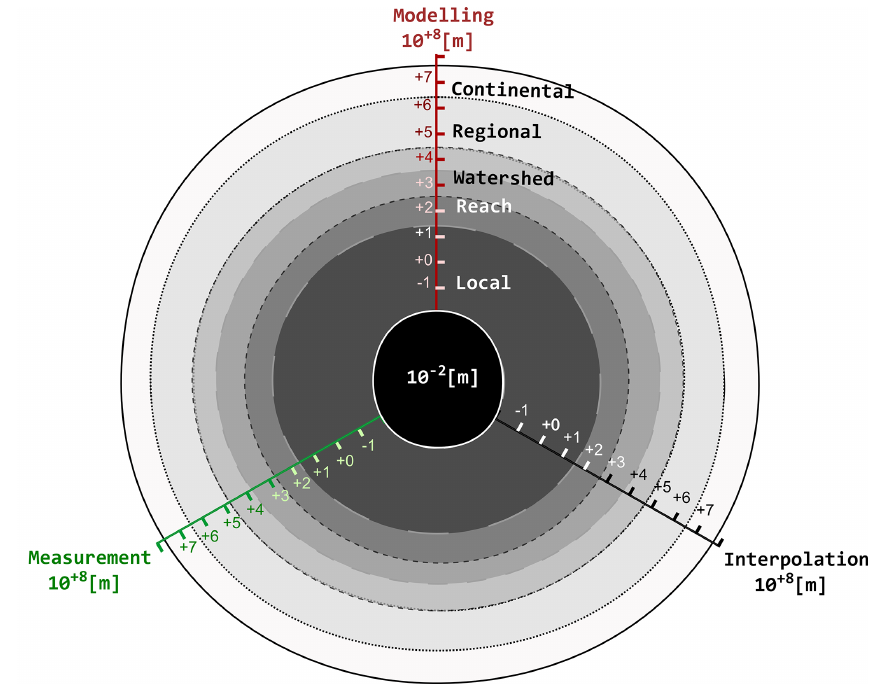
Figure 4. MIM methodological space. Axis in logarithmic